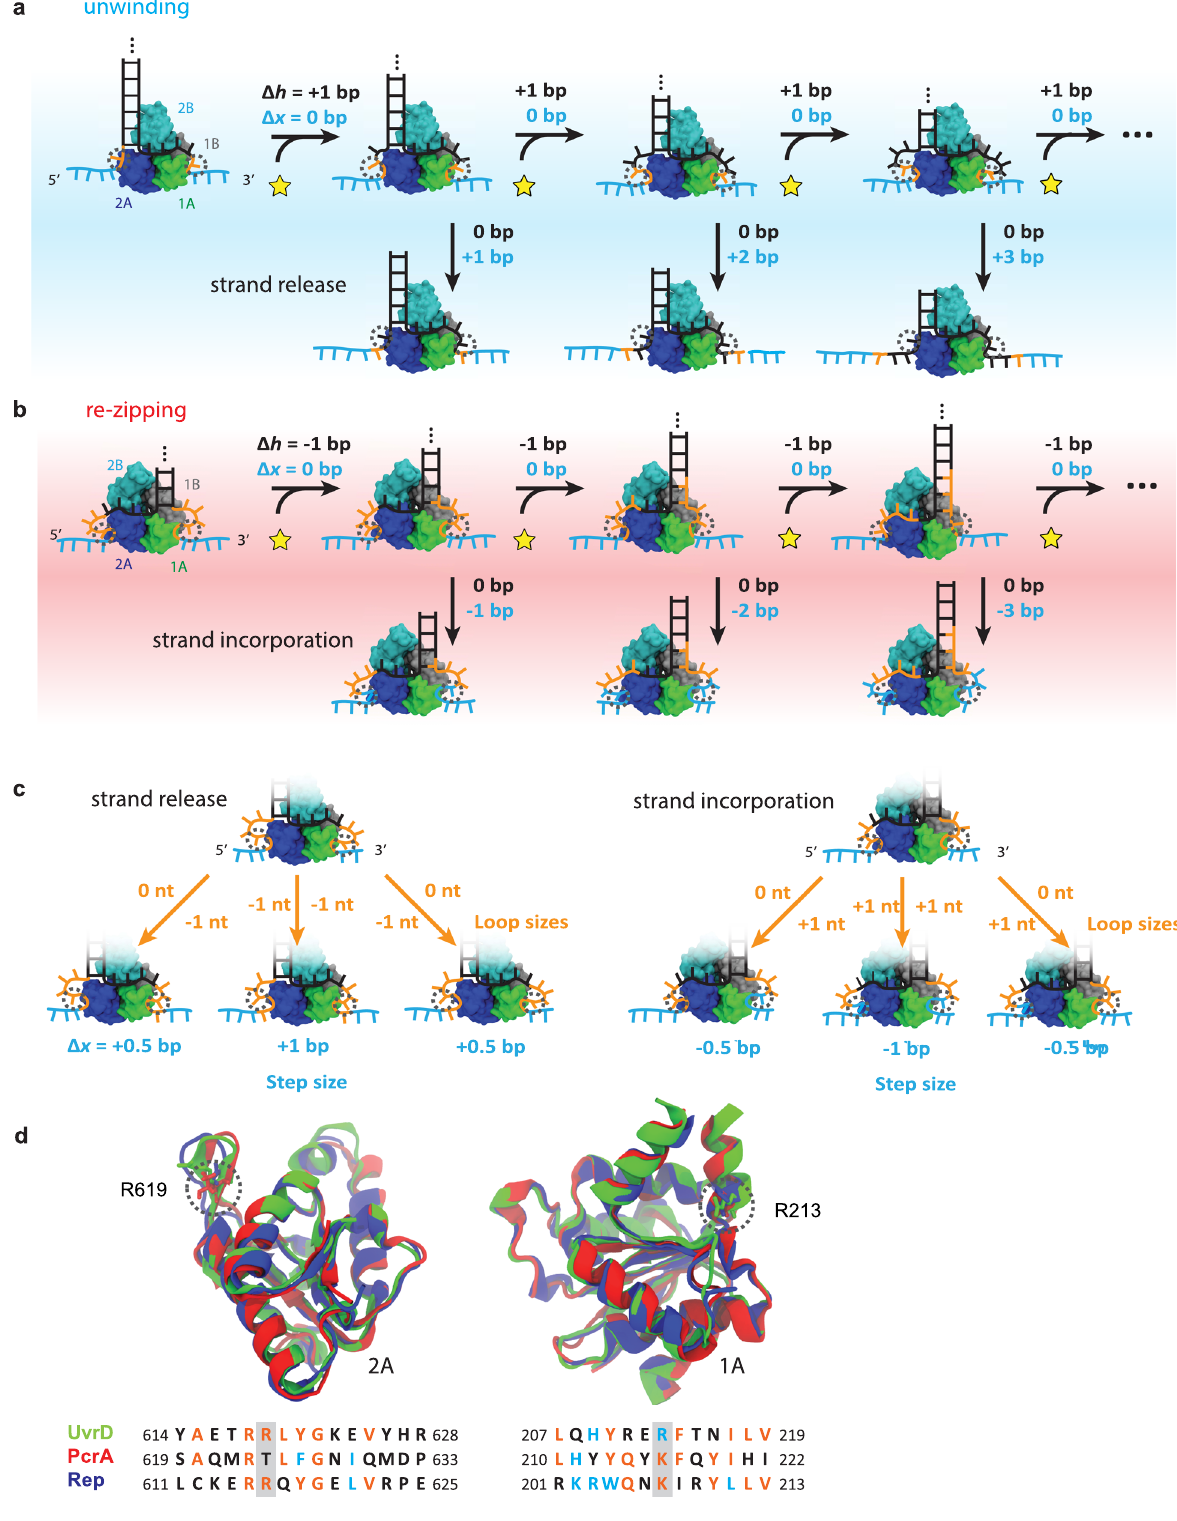
a different type of strain. Here, loop shortening beyond a mini- mum loop size could stretch loop-protein contacts too far, trig- gering ssDNA dissociation (Fig. 5b). The next favorable contacts to form would correspond to more energetically stable longer loops (~3 nt longer on average), i.e. a loop incorporation process representing the reverse of the process depicted in Fig. 3b. We note that this model for re-zipping is more speculative, as there